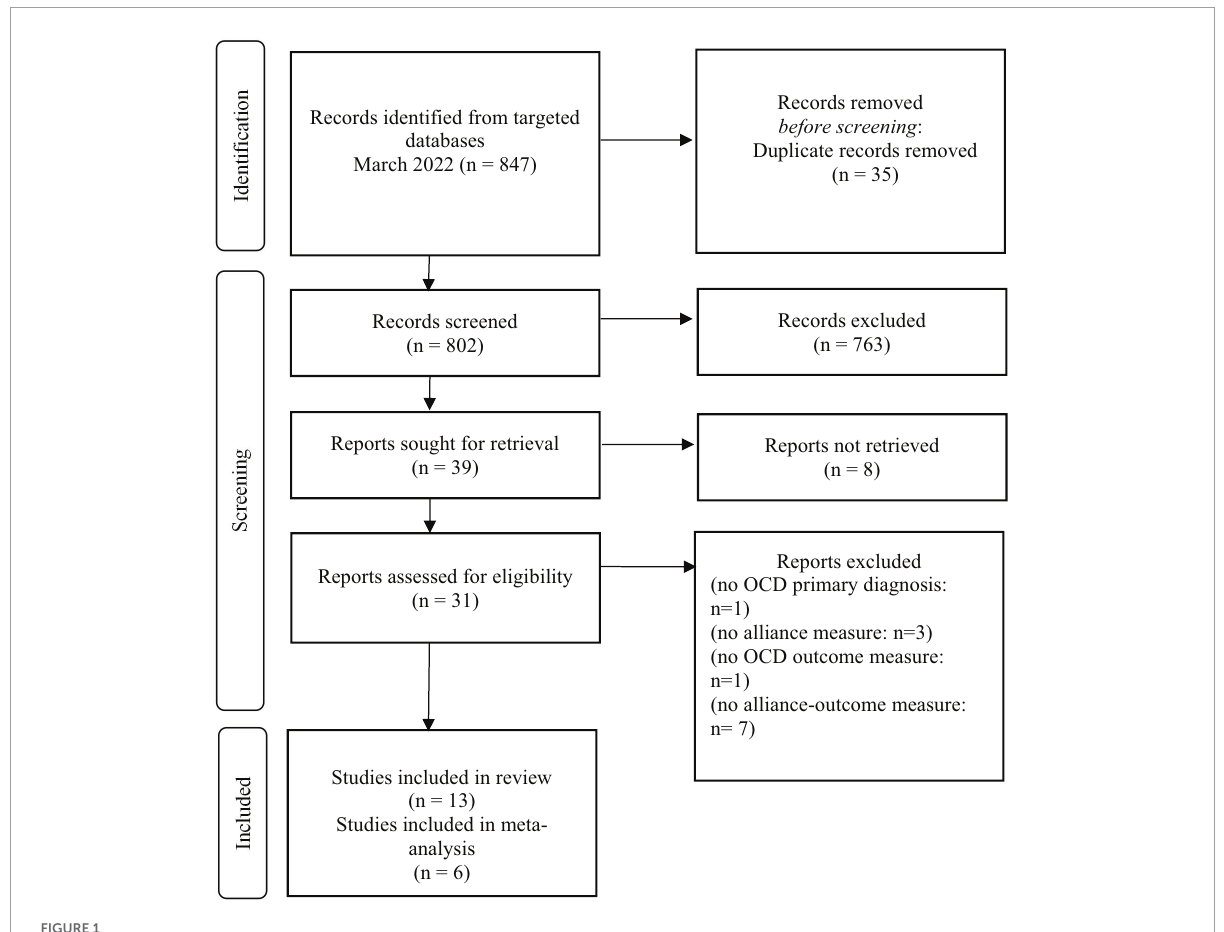
FIGURE1 Flowchart of selection process for included